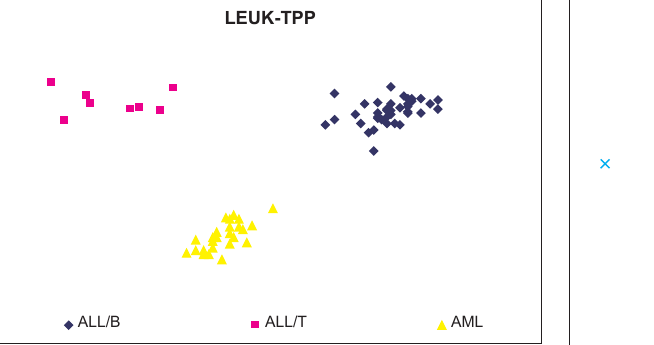
Figure 5.1: Two-Dimensional View of LEUK data set produced by TPP method showing a clear separation between all classes.